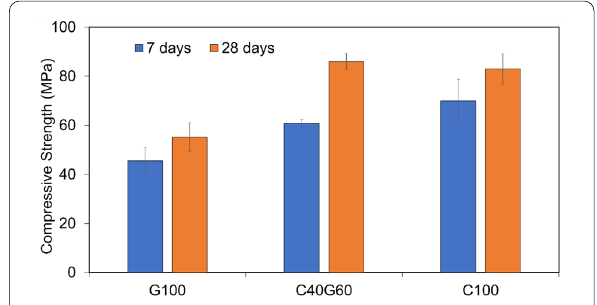
Fig. 13 Compressive strength of the